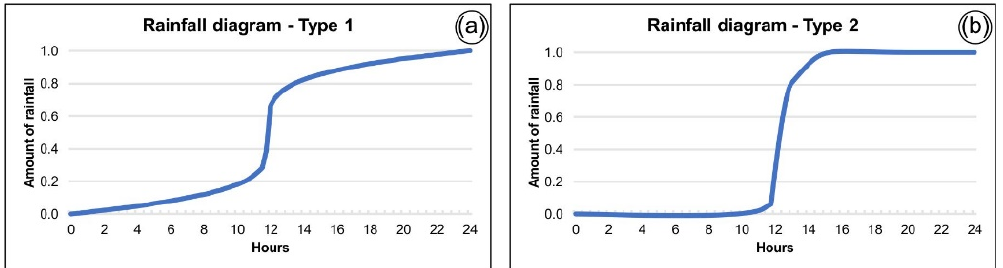
Figure 13. Rainfall distribution curves used in the FLO-2D simulation: ( a ) with a total cumulate rainfall of 110 mm distributed over 24 h (representing to the March 2015 event); ( b ) with a total cumulate rainfall of 75 mm distributed over 4 h (representing the June 2018 event).